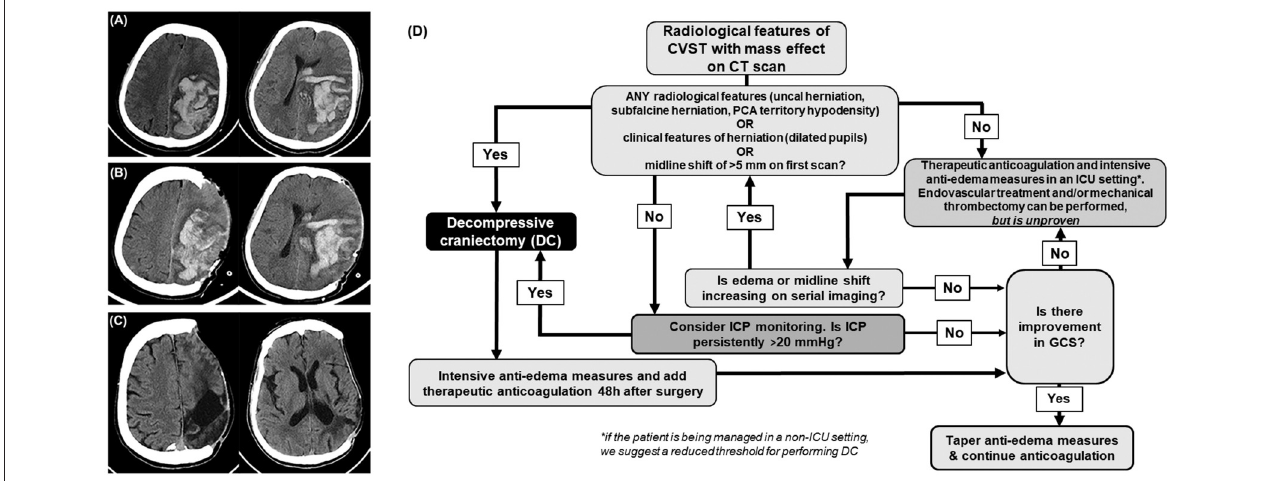
FIGURE 1 | Cerebral venous sinus thrombosis (CVST). (A) Computed tomography depicts a confluence of blotchy areas of bleed typically seen in hemorrhagic CVST with mass effect. (B) Day 1, and (C) 8 months, post decompressive craniectomy. (D) Flowchart outlining the management of CVST. CT, computed tomography; ICU, intensive care unit. GCS, Glasgow coma scale; ICP, intracranial